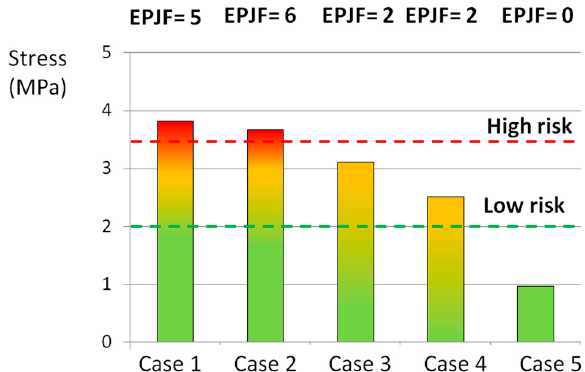
Figure 6. Average tensile stress generated by the loading cases listed in Table 1 at the interface between the annulus and the caudal endplate in the POST LAT-2 section. The red and the green lines indicated the thresholds identified as “high risk” and “low risk” of failure, respectively.